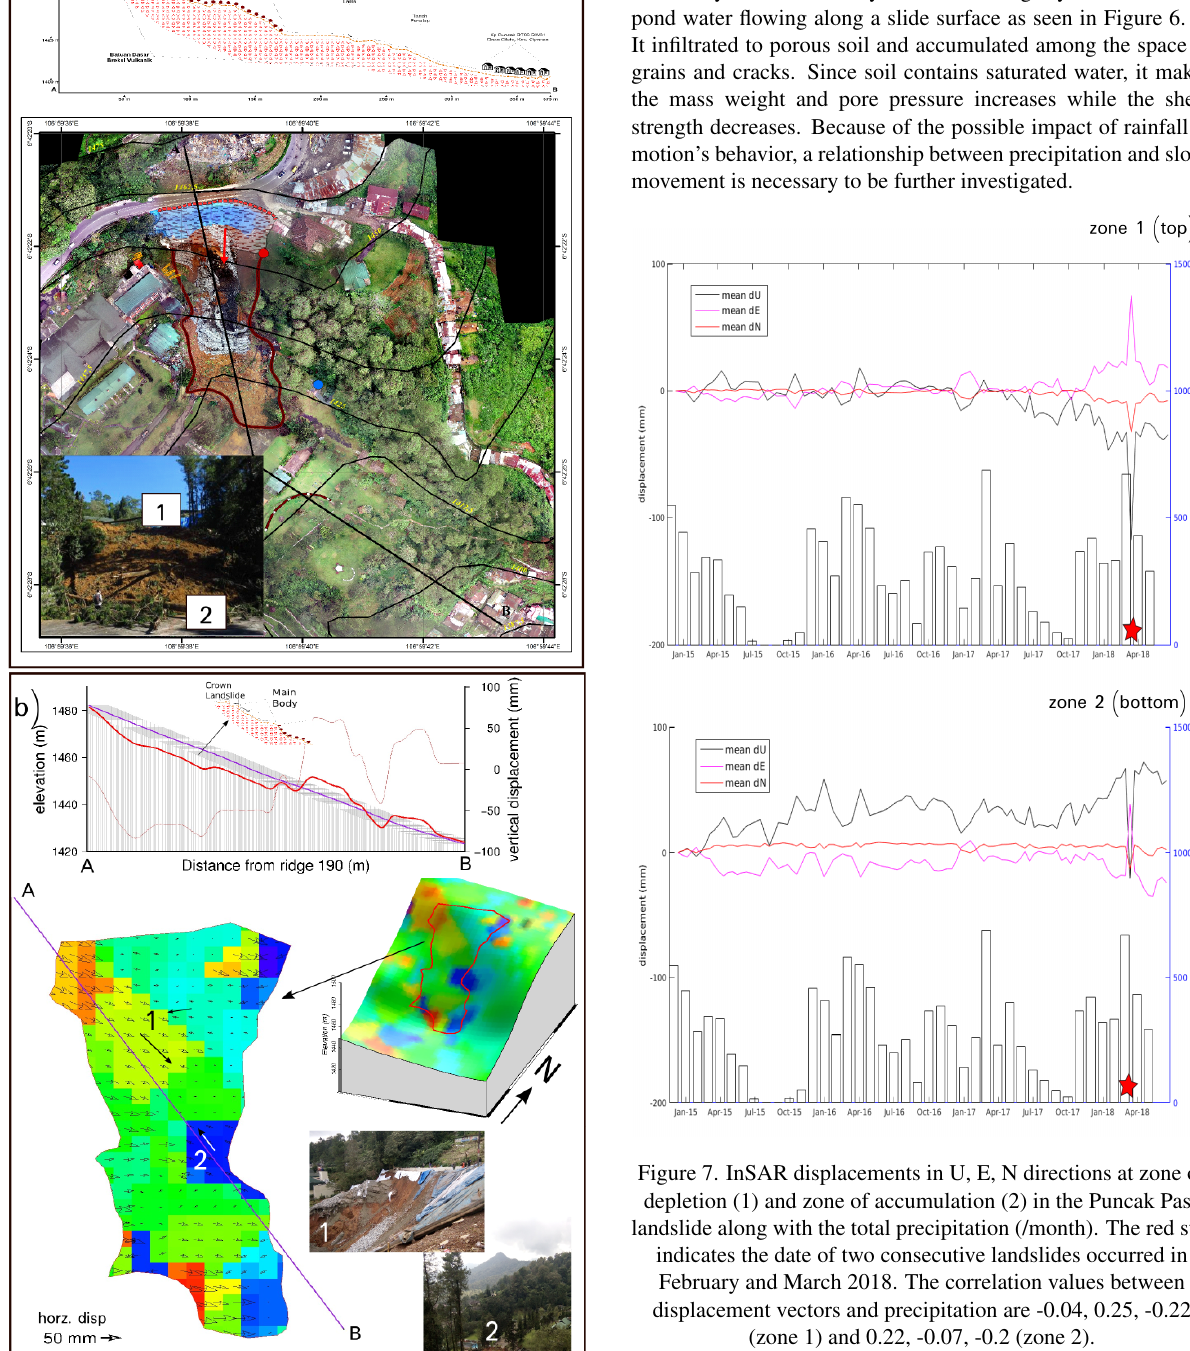
3D vectors samples at zone 1 determined as the depletion area with 18 PS scatters [-6.706 o - -6.705 o S; 106.993 o - 106.994 o E]) are compared to the total precipitation (per month [mm]) Figure 6. a) An aerial photography after the landslide, on 28 th recorded by the Citeko Station. The total rainfall intensities March 2018 occurred. b) The 3D motion field generated by the recorded from October 2016 to February 2017 for five months InSAR from November 2014 to January 2018. The pictures (rainy season) was 1788 mm with the highest intensity in Febru- show a profile of the cumulative vertical displacement occurred ary 2017, 688.5 mm. Figure 7 (top) shows that all vectors within at the Puncak Pass which the horizontal displacement moved this time indicate maximum cumulative motion to -47 mm, 23 from the road to the lower surface’s elevation placed a few mm, -10 mm for dU, dE and dN, respectively. buildings owned by a resort hotel.